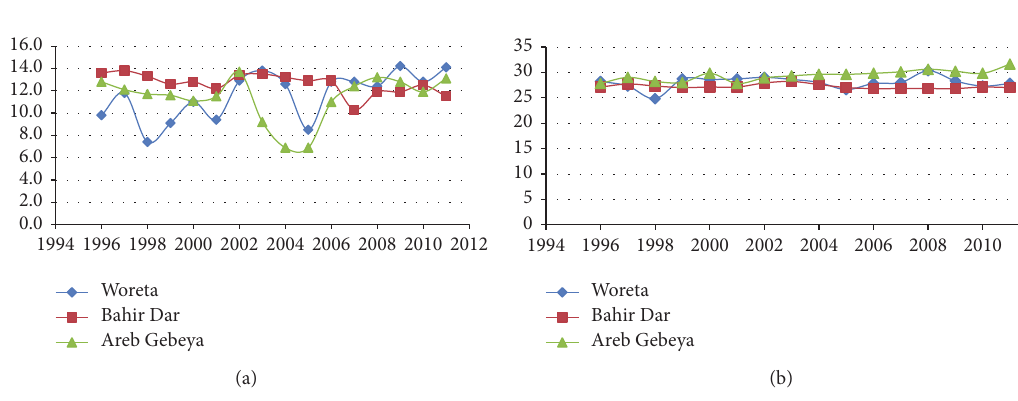
Figure 2: Temperature distribution across years of the working districts city: (a) minimum temperature (b) maximum temperature.